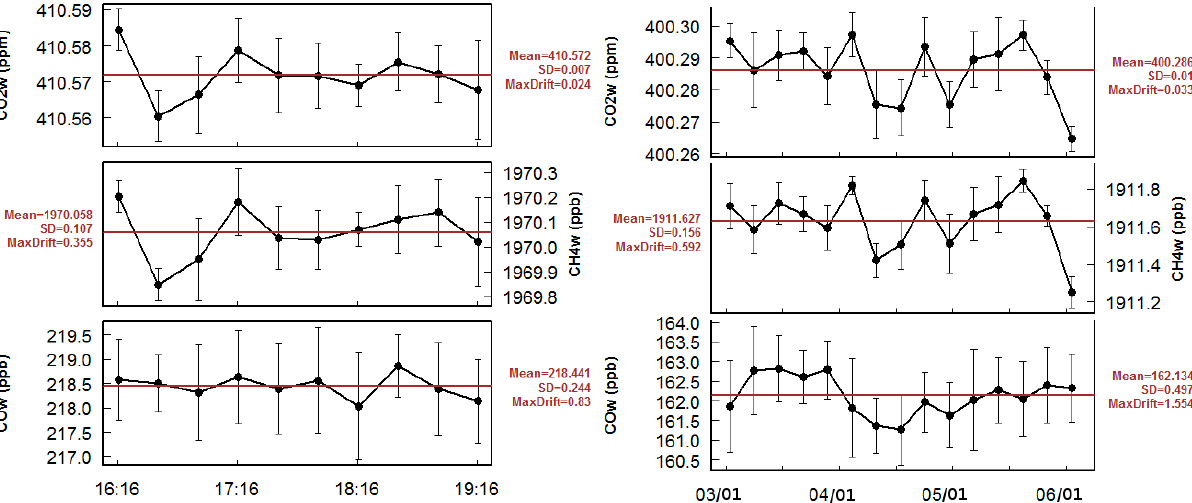
Figure A2. Short-term and long-term repeatability for the three species. First panel: short-term repeatability. Second panel: long-term re-